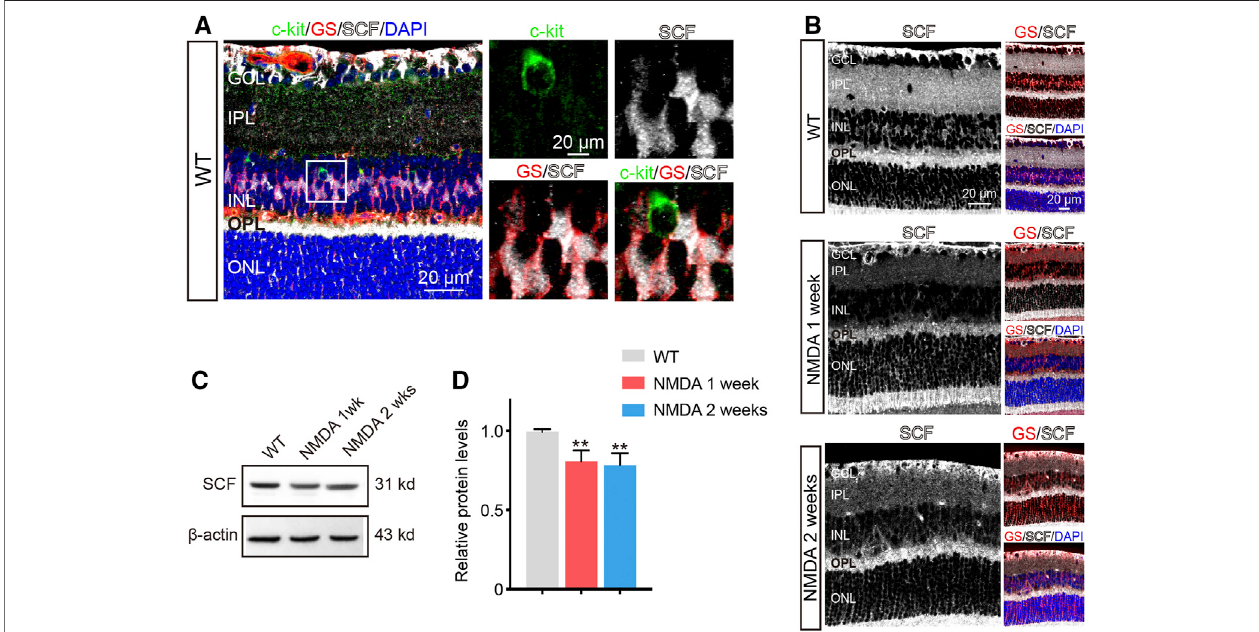
FIGURE 2 | The Expression of SCF was Downregulated after NMDA Treatment. (A) c-kit-positive cells (green), glutamine synthetase (GS)-positive cells (red) and SCF-positive cells (white) located in the inner nuclear layer (INL). The white box in left panel was shown at higher magni fi cation in right panels. (B) Immuno fl uorescence stainingofSCF(white)andGS(red)intheretinasofWTandNMDA-treatedmice.Scalebarsrepresented20 μ m. (C,D) TheexpressionofSCFwereanalyzedbyWestern blottinganalysis (C) and quantitated byImageJ and plotted asthemeanexpression ±SD ( n =3eyes/group, ** p < 0.01 vsWT) (D) .The level ofSCF wascorrected for β -actin loading control and normalized to the levels of control